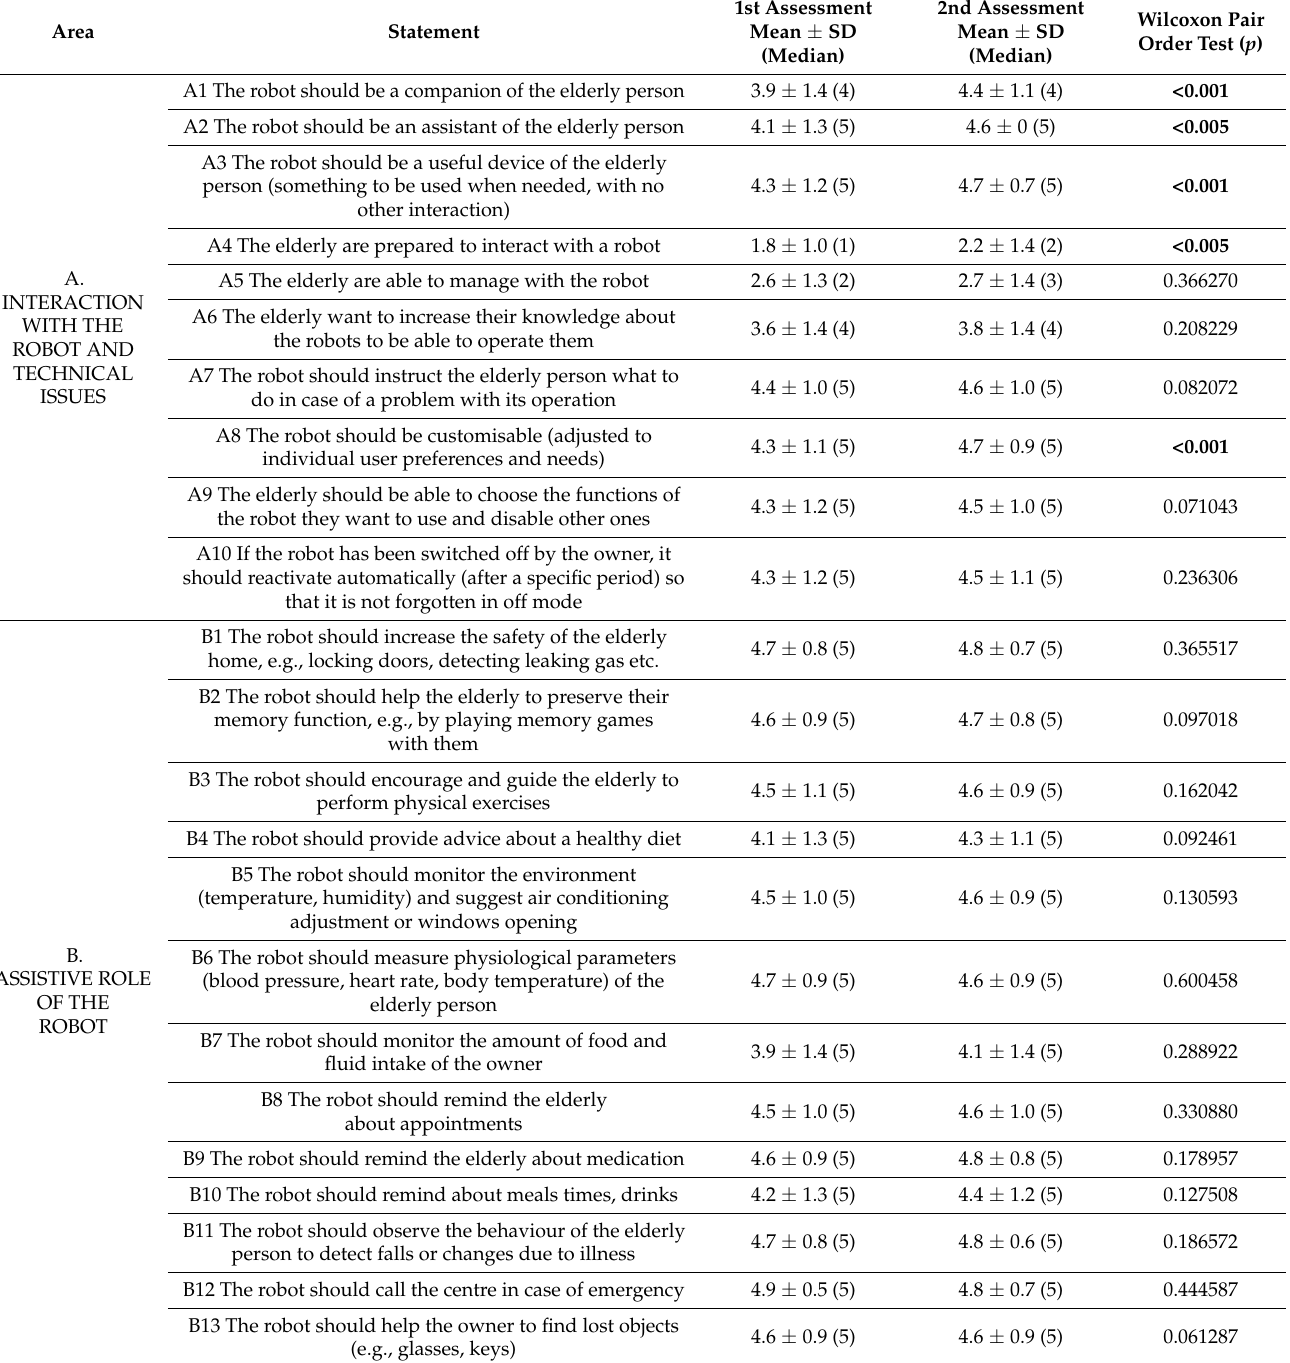
Table 1. UNRAQ results before and after interaction with the